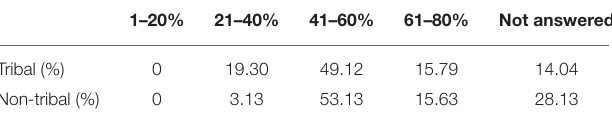
constraints; lack of legume processing units and fencing materials ( Figure 1 ).